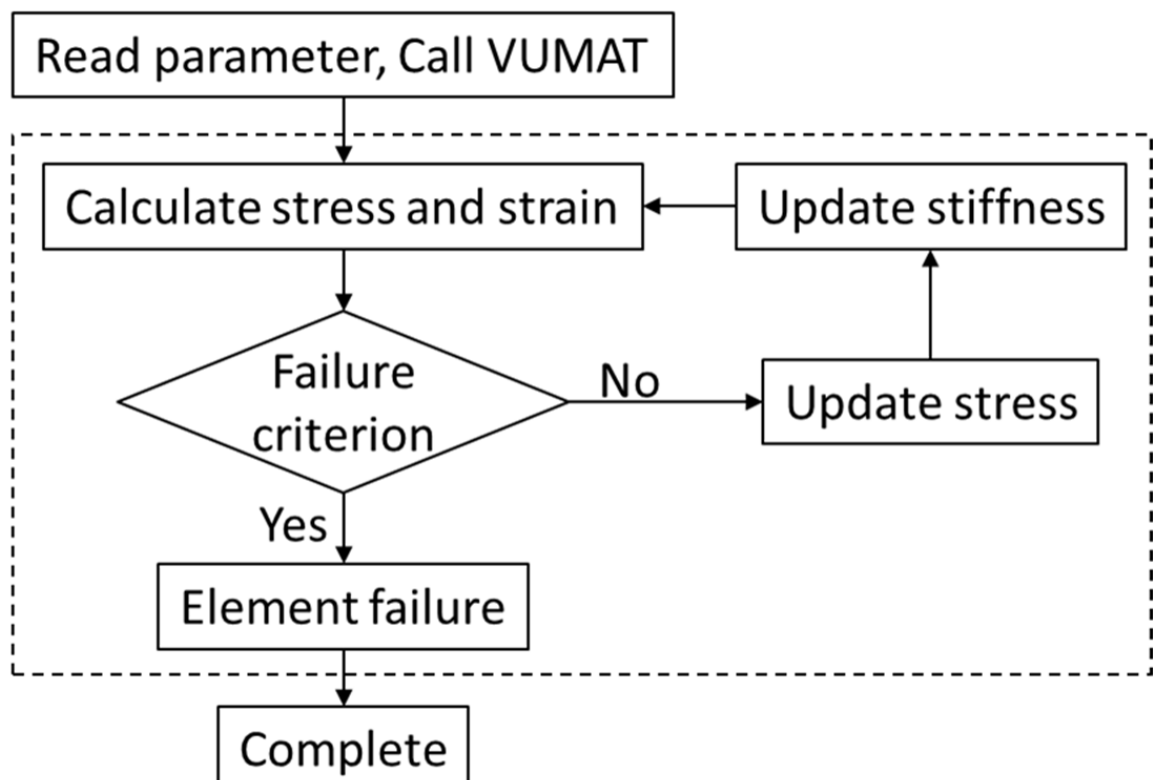
Figure 4. Calculation flowchart of ABAQUS calling user subroutine VUMAT.